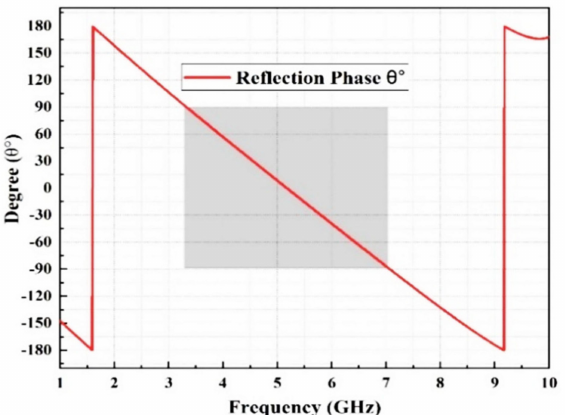
Figure 6. Simulated reflection phase.